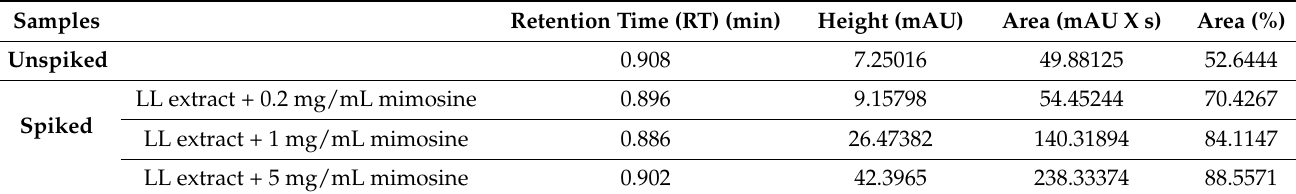
from the M9 buffer.